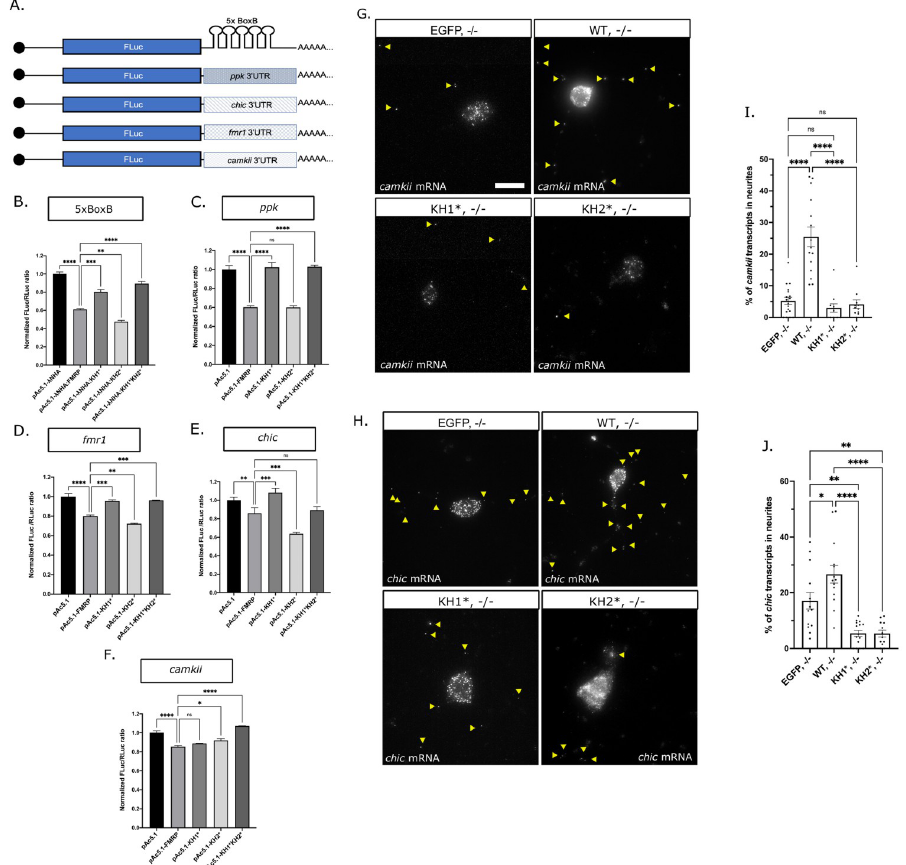
Fig 7. FXS-causing mutations disrupt translation and RNA transport. (A) Diagram of the FLuc reporters used in this study fused to the SV40 3’UTR containing the 5xBoxB sequence or to the 3’UTR’s of known mRNA targets of dFMRP. Luciferase assays of (B) λ N:HA-tethered FMRP-mutants repression of the 5xBoxB FLuc reporter or the untethered FMRP-mutants repression of FLuc fused to the (C) pickpocket ( ppk ), (D) fmr1 , (E) chickadee (chic) or (F) camkii 3’UTR. FLuc/RLuc ratios were normalized to empty vector ratios. Graph shows repression of the FLuc reporter by empty vector or FXS-causing point mutants compared to pAc5 . 1- λ NHA : FMRP(B) or pAc5 . 1-FMRP (C-F) (mean ± SE; one-way ANOVA). Representative images of camkii (G) or chic (H) mRNA smFISH in primary MNs. Yellow arrowheads in images are distinguishing transcripts found in neurites. Scale bars = 10 μ m. Quantification of the average number of camkii (I) or chic (J) transcripts in neurites of each of the FMRP mutants (mean ± SE of 11–18 MNs; unpaired t test). In all graphs: � p < 0.05, �� p < 0.01, ��� p < 0.001, ���� p <